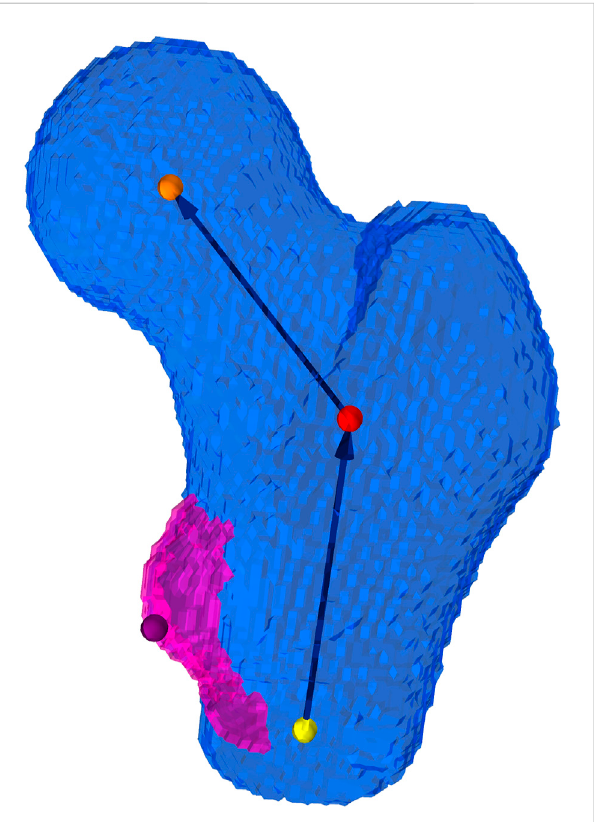
Implicitcoordinatesystemoftheproximalfemur.Thecoordinate system consists of an estimate of the femoral neck axis and the proximal shaft axis of the femur, which intersect at a closest point (red dot) de fi ned from two generally not intersecting initial guesses. The orange dot depicts the center of the femoral head, the yellow depicts thedistalpoint used for thede fi nition ofthefemoral shaftaxis, and the purple dot is the peak of the lesser